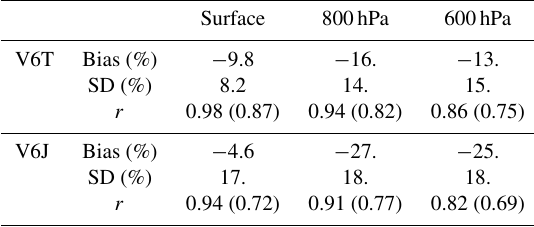
Table 1. MOPITT validation results based on in situ CO verti- cal profiles acquired at four sites in the Amazon Basin from 2010 to 2013. Correlation coefficients shown in parentheses indicate re- sults obtained when a priori influence is excluded, as described in Sect.